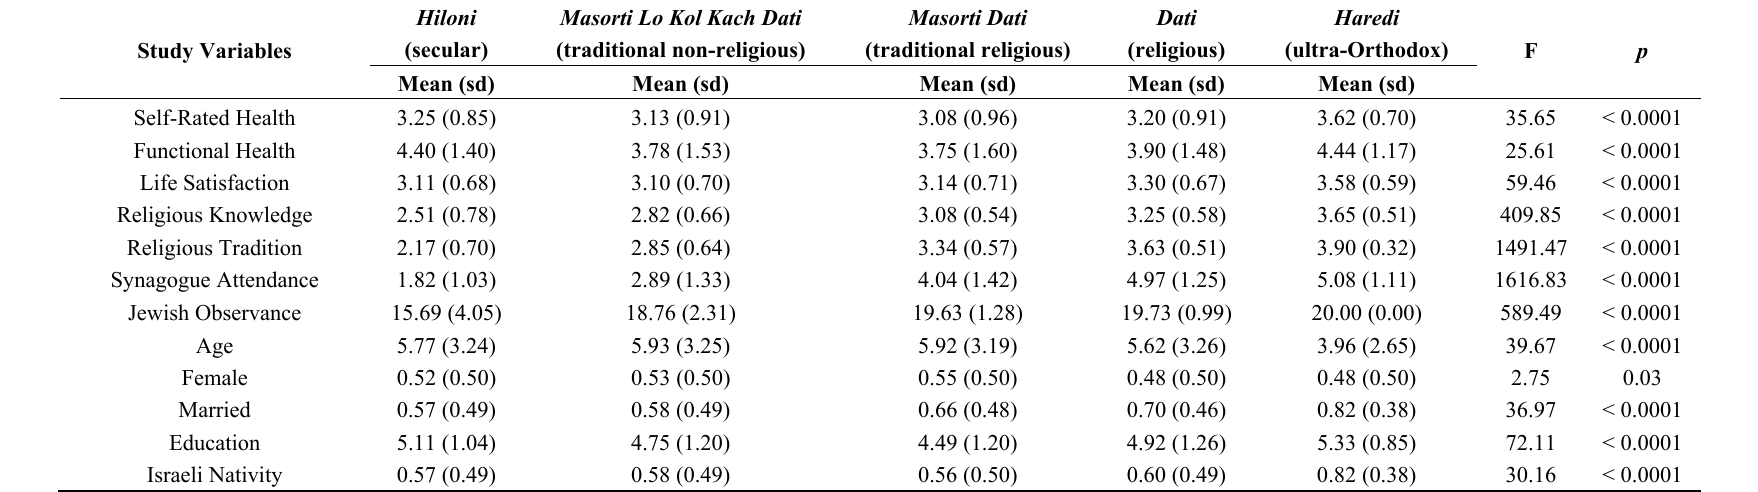
Table 2. ANOVA results for study variables, by Jewish religious